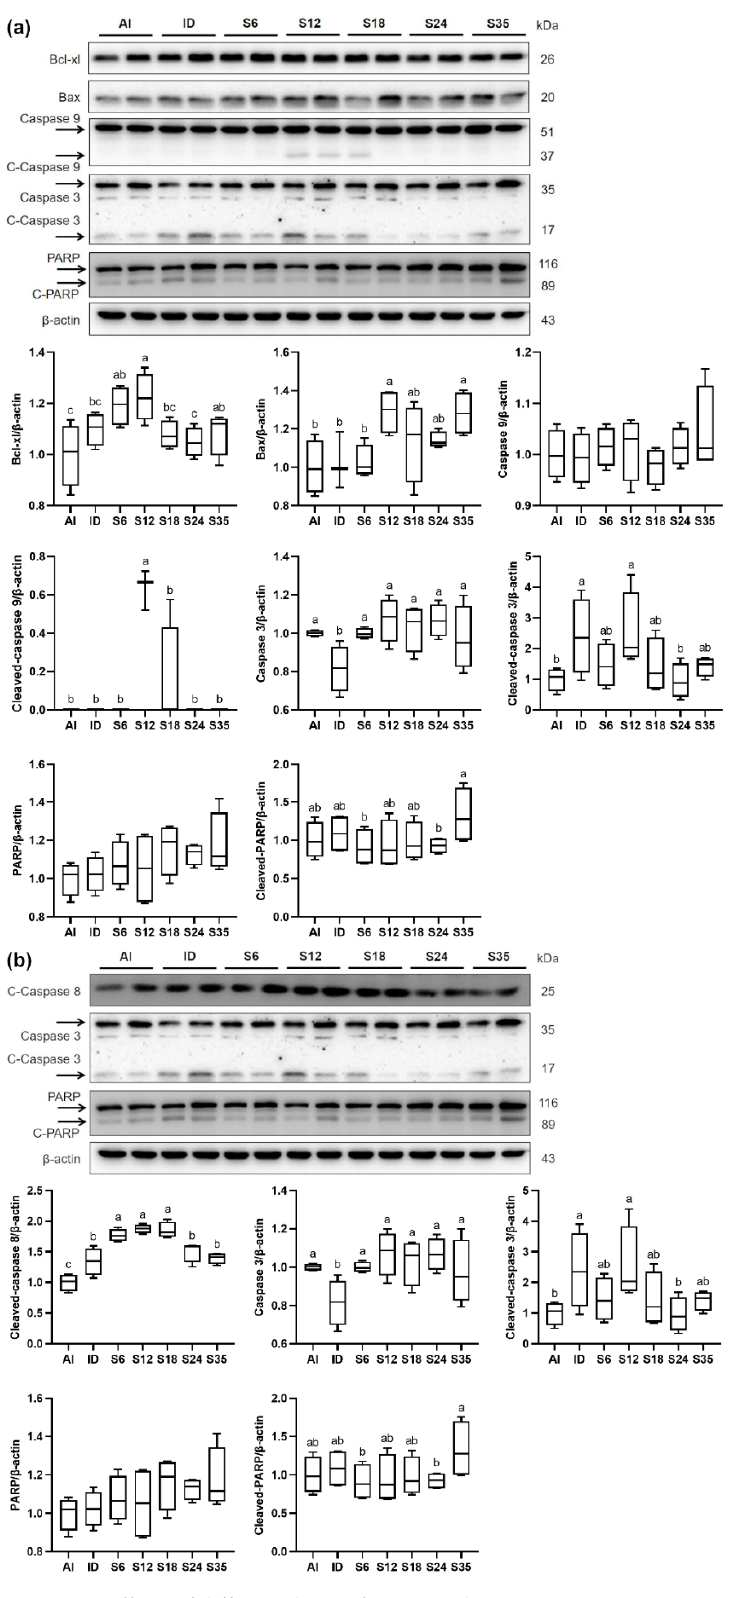
Figure 11. Effects of different doses of iron supplementation on protein expressions of markers related to the testicular ( a ) intrinsic apoptosis pathway and ( b ) extrinsic apoptosis pathway in iron-deficient rats. Values are presented as median (interquartile range, IQR). n = 3–4 per group. Values not sharing the same letters are significantly different at p < 0.05.